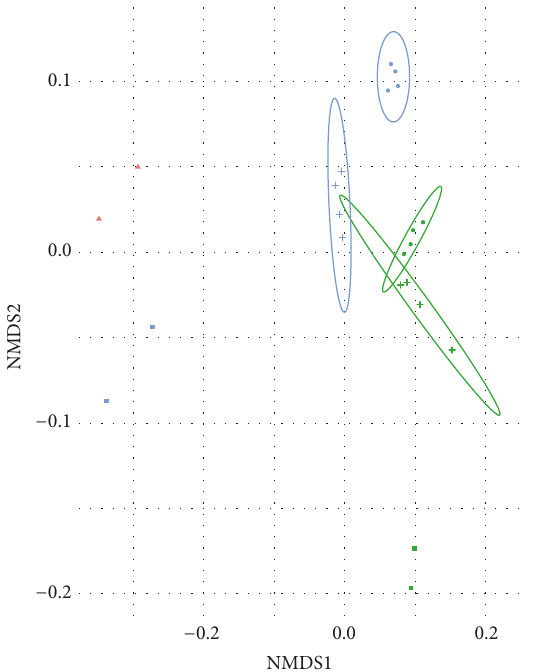
Figure 3: Ordination plots of a nonmetric multidimensional scaling (NMDS) for the microbial communities from SW (inflow) and SS- and IGBS-inoculated MFCs. Blue color indicates microbial commu- nities derived from SS, green color indicates microbial communities derived from IGBS, and red color indicates microbial communities derived from SW (circles, anodic microbial communities; crosses, planktonic microbial communities; squares, microbial communities of inoculums; triangles, SW microbial community). NMDS was based on Bray-Curtis distances of prokaryotic species